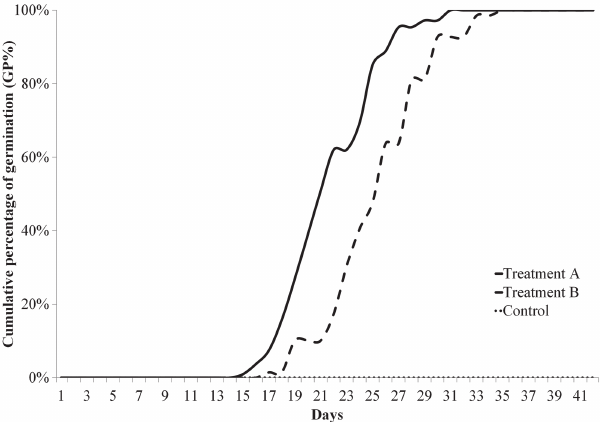
Fig. 4. Germination Speed Index (GSI) of Euterpe oleracea ’s intact seeds from Lithodoras dorsalis ’ stomachs (Treatment A); from the forest, with epicarp and mesocarp removed manually (Treatment B); and originating from the forest with epicarp and mesocarp intact (Treatment C) at the Amazon River mouth, Brazil, from July 2010 to June